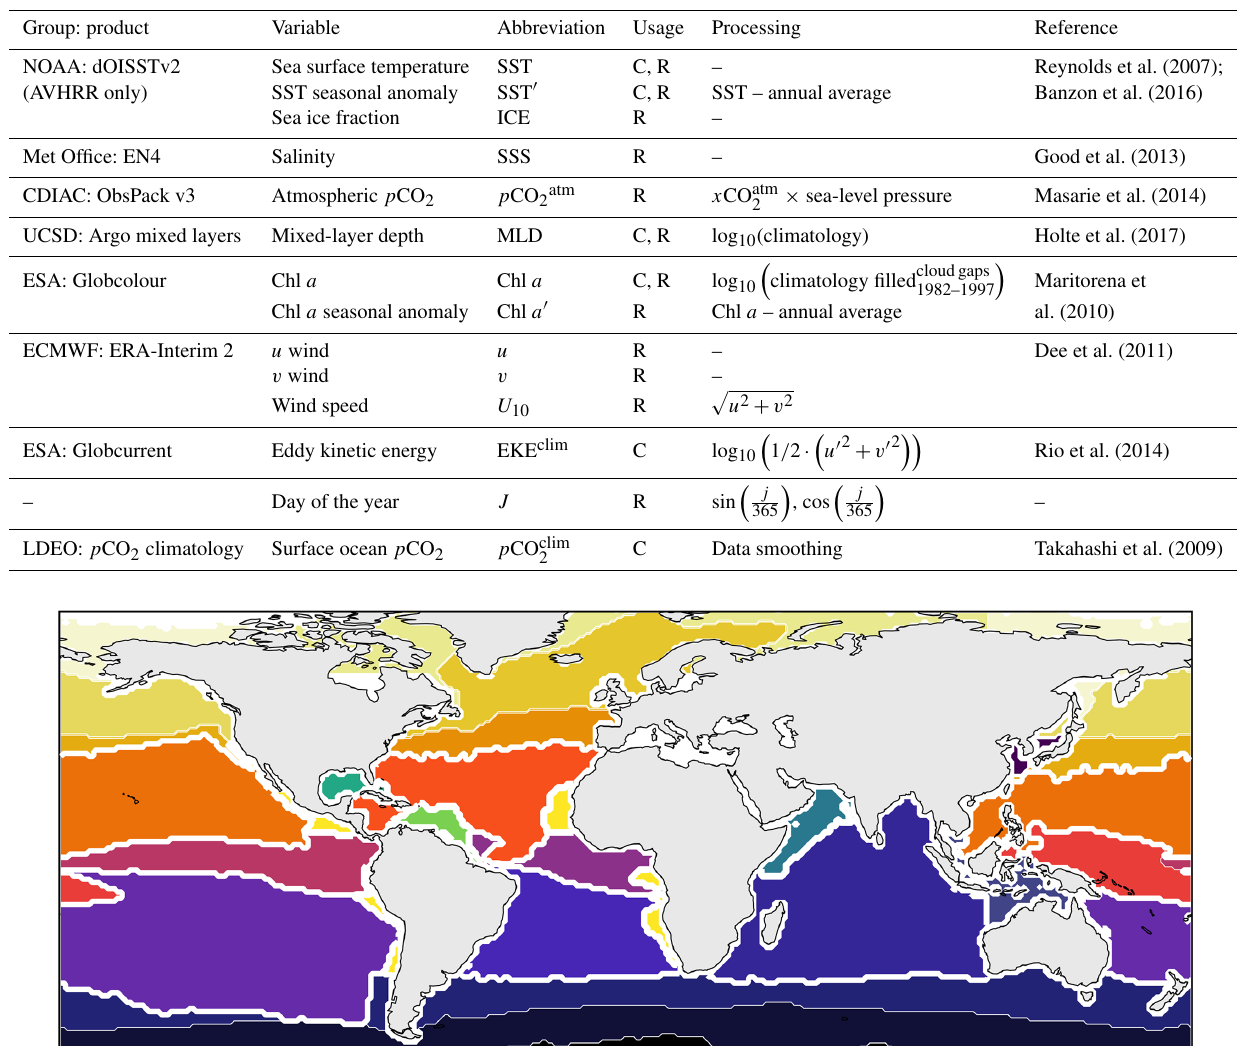
Table 1. Summary of the products, variables and data processing steps used for feature variables. The “usage” column indicates the features that are used for the clustering step (identified by C) and for the regression step (identified by R). Abbreviations are used in Fig. 1 and throughout the text. Basic data processing is described in the text with details in the Supplement (Sect. S1).